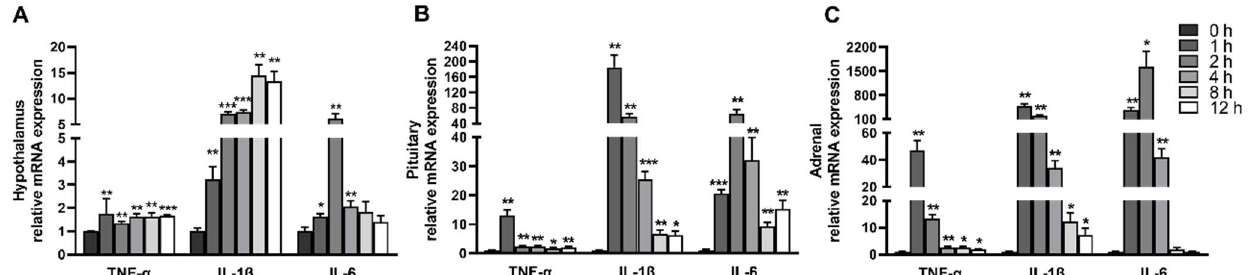
Figure 3. LPS induces dynamic inflammation of the hypothalamus, pituitary, and adrenal gland. ( A ) mRNA expression of TNF- α , IL-1 β , and IL-6 in the hypothalamus. ( B ) mRNA expression of TNF- α , IL-1 β , and IL-6 in the pituitarygland. ( C ) mRNA expression of TNF- α , IL-1 β , and IL-6 in the adrenal gland. The pigs in LPS groups were injected with LPS at 100 µ g/kg BW, and then were sacrificed at 1, 2, 4, 8, or 12 h after LPS challenge. Values are means ± SEM, n = 6. * p < 0.05, ** p < 0.01, and *** p < 0.001, significantly different from the control group (0 h). TNF- α , tumor necrosis factor α ; IL-1 β , interleukin-1 β ; IL-6 , interleukin-6.